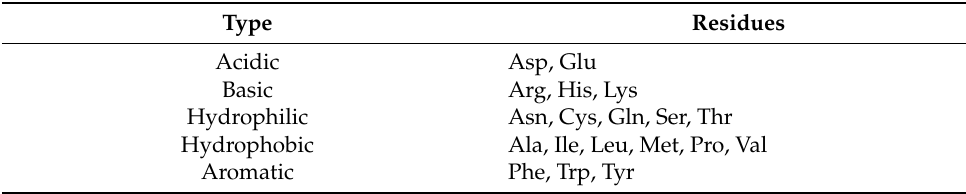
Table 2. Types of residues used in this study. Note that glycine is not included in this table, since it does not have any Cβ atom s.